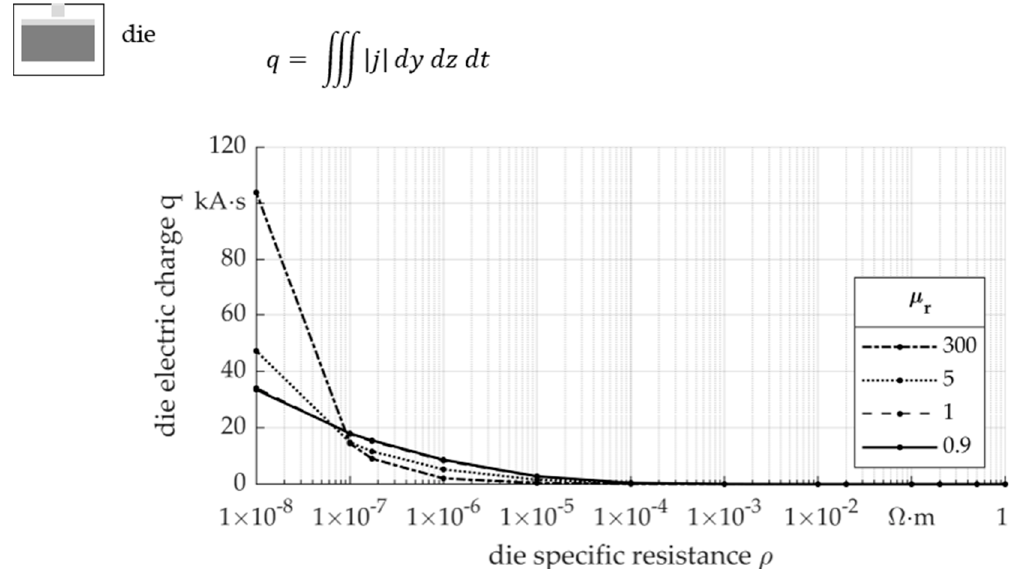
Figure 8. Integral of the current density j in the die volume over time in respect of the specific resistance ρ of the die material.